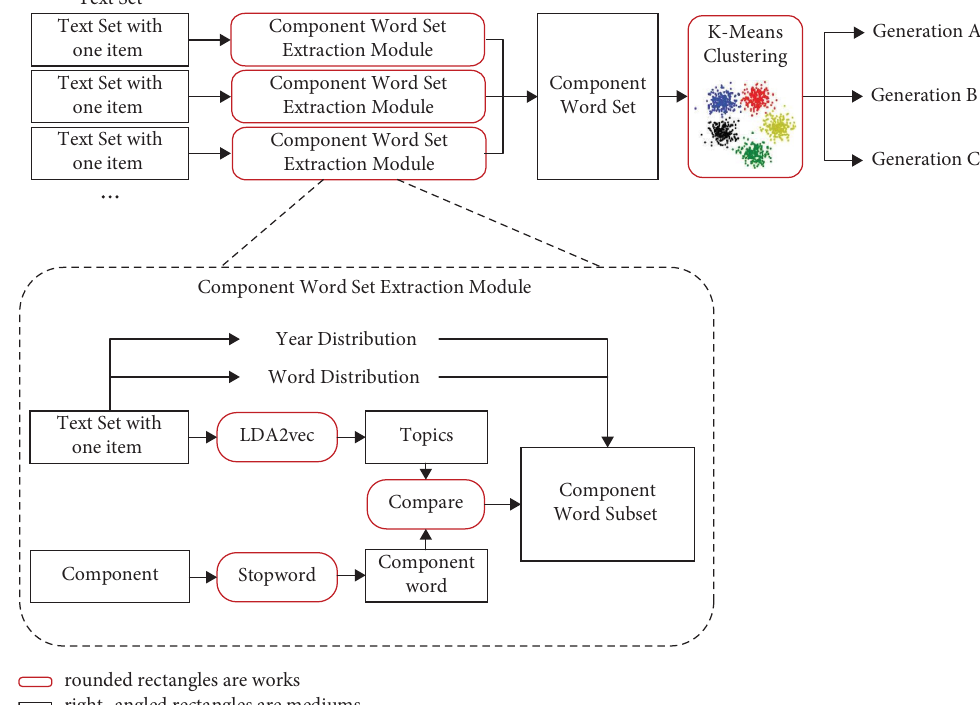
Figure 2: Overview of our method. In each item, a component word set extraction module is proposed to collect component word set and then clusters its component with year by K-means to get generation feature. An LDA2vec work is used in the component word set extraction module to get the relationship between the component and other features.